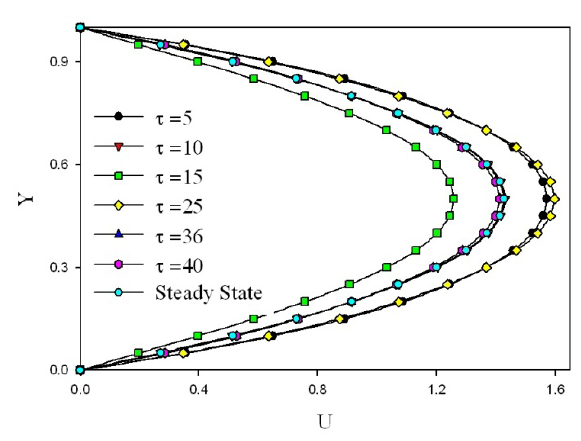
Fig. 13. Temporal variation of pressure for different volume fraction at Re = 100, St=0.1 and A